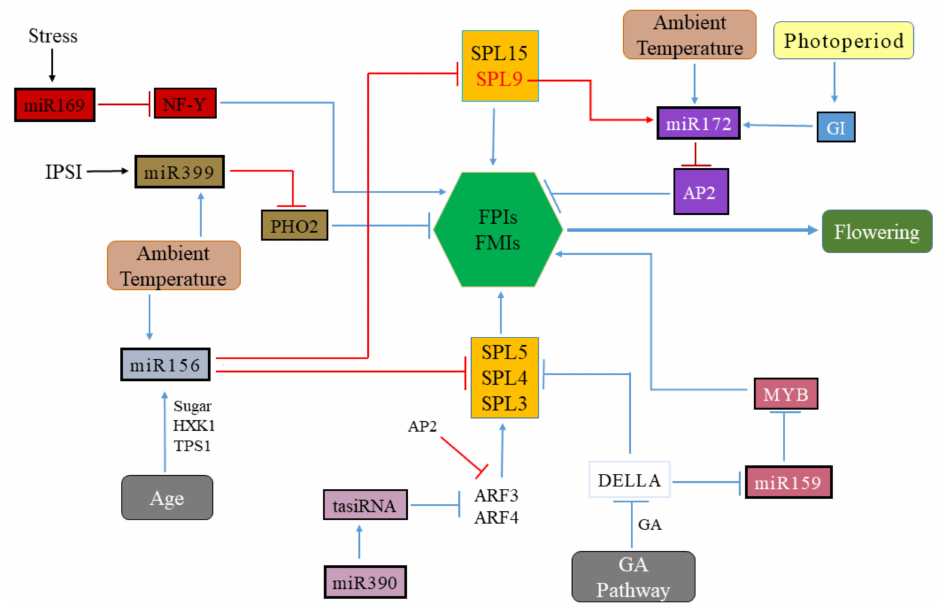
Figure 2. Analysis of di ff erent miRNAs families and their target genes implicated in the regulation of flower induction. The accumulation of miR156 subsequently declines with an increase in plant age, other factors such as sugar (HXK1) accumulation and the ambient temperature gradually repress miRNA156 expression, resulting in rising levels of SPL family genes. MiR172 expression is positively regulated by GI, that leads to the down-regulation of AP2-type floral repressors, miR172 is also regulated by ambient temperature. The miR159 is regulated by the GA pathway and in turn, miR159 regulates the MYB transcription factors. The DELLA protein represses the expression of miR159 and the SPL3 / 4 / 5 genes. The miR390-ARF3 / 4 module regulates floral transition indirectly by inducing the production of ta-siRNAs from the TAS3 locus, through putative control over SPL gene expression. The ambient temperature-induced miR399-PHO2 module and stress-induced miR169-NF-Y module regulate floral induction by regulating the expression of floral meristem identity genes. Overall, miRNAs can either promote or inhibit the expression of the FMI (floral meristem identity genes) and / or FPI (floral pathway integrator), thereby promoting or delaying the onset of flowering, respectively. AP2, APETALA2; ARF, AUXIN RESPONSE FACTOR; HXK1, hexokinase; GI, GIGANTEA; NF-Y, NUCLEAR FACTOR Y; GA, gibberellic acid; SPL, SQUAMOSA PROMOTER-BINDING PROTEIN-LIKE; PHO2, PHOSPHATE 2; ta-siRNA, trans-acting siRNA; TPS1, TREHALOSE-6-PHOSPHATE SYNTHASE1; PHO2, PHOSPHATE 2